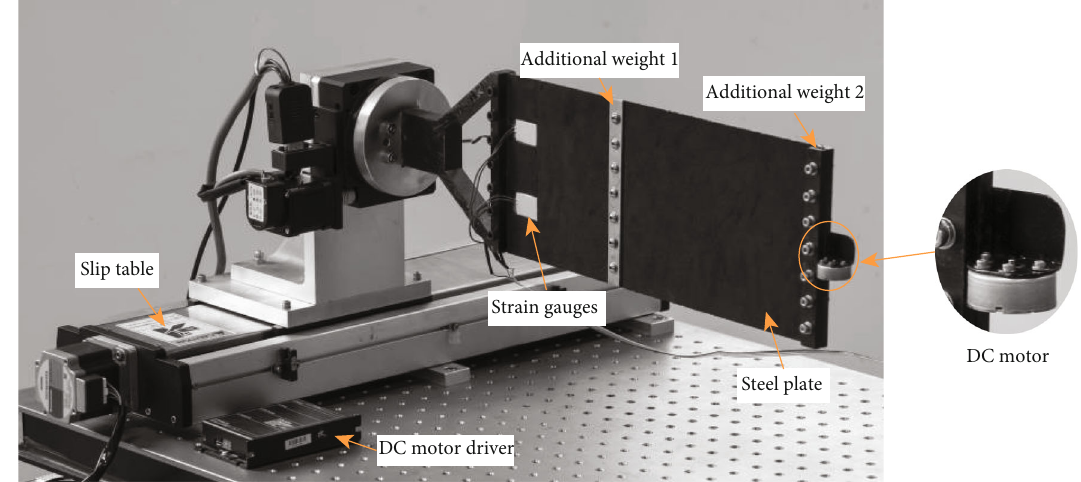
Figure 9: Photograph of the experimental setup for vibration suppression.